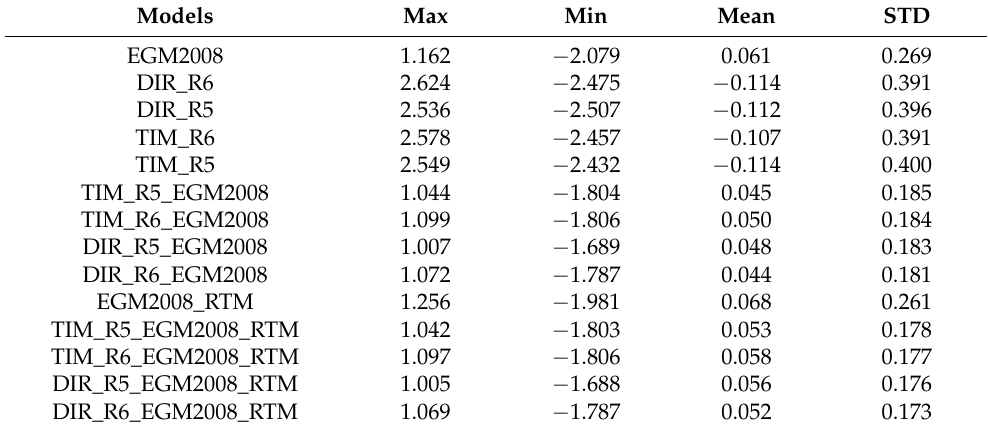
Figure 9. The RTM contribution to quasi-geoid height in China. Table 3. Statistics of the height anomaly differences between GNSS/leveling and the GFMs. Unit: